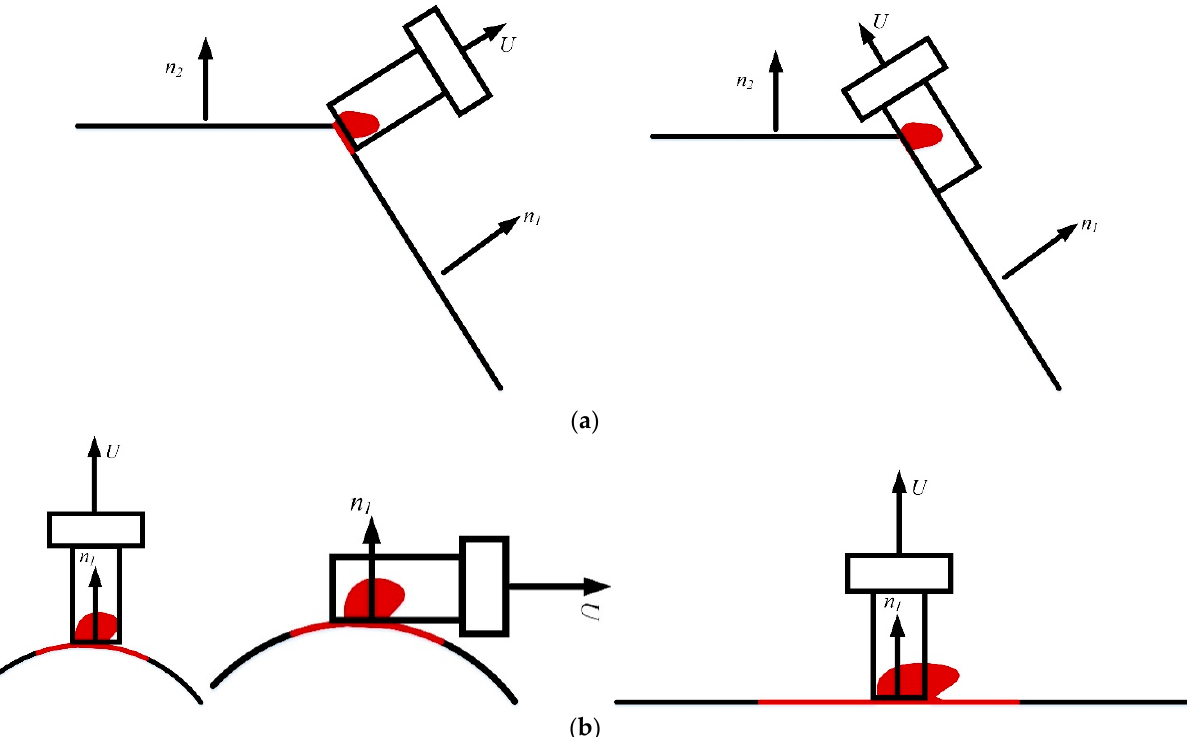
Figure 7. Deburring trajectory generation. ( a ) workpiece edges. ( b ) parting lines/risers.